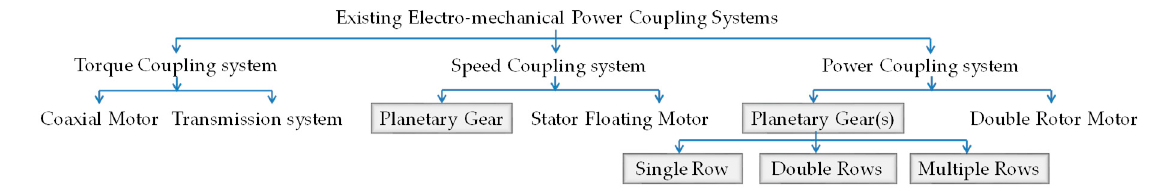
Figure 4. Existing electromechanical power coupling systems.